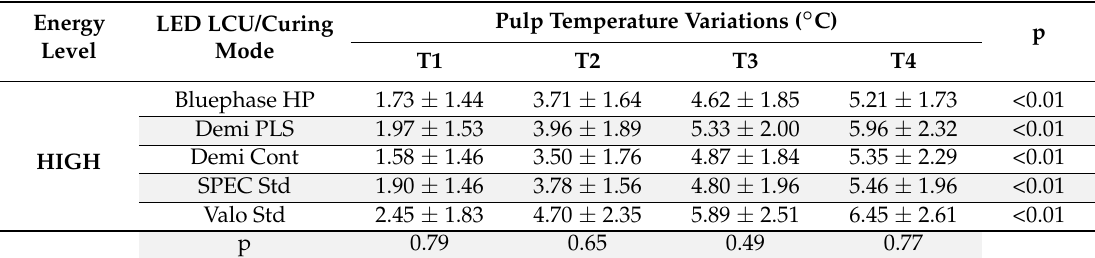
Table 1. Mean pulp temperature variation above baseline value measured at the end of each four light-curing steps among high-energy-level curing modes.